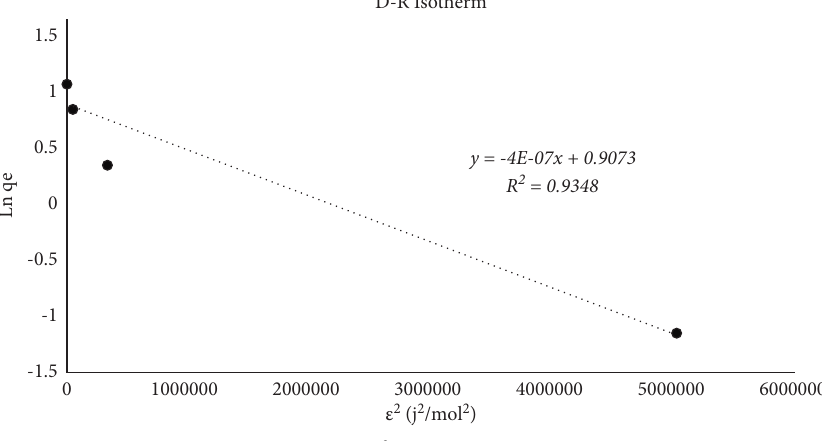
Figure 10: Ln( q 2 , D-R isotherm, TT powder. e ) to ε Table 5: Constants of adsorption isotherms determined for MG powder.